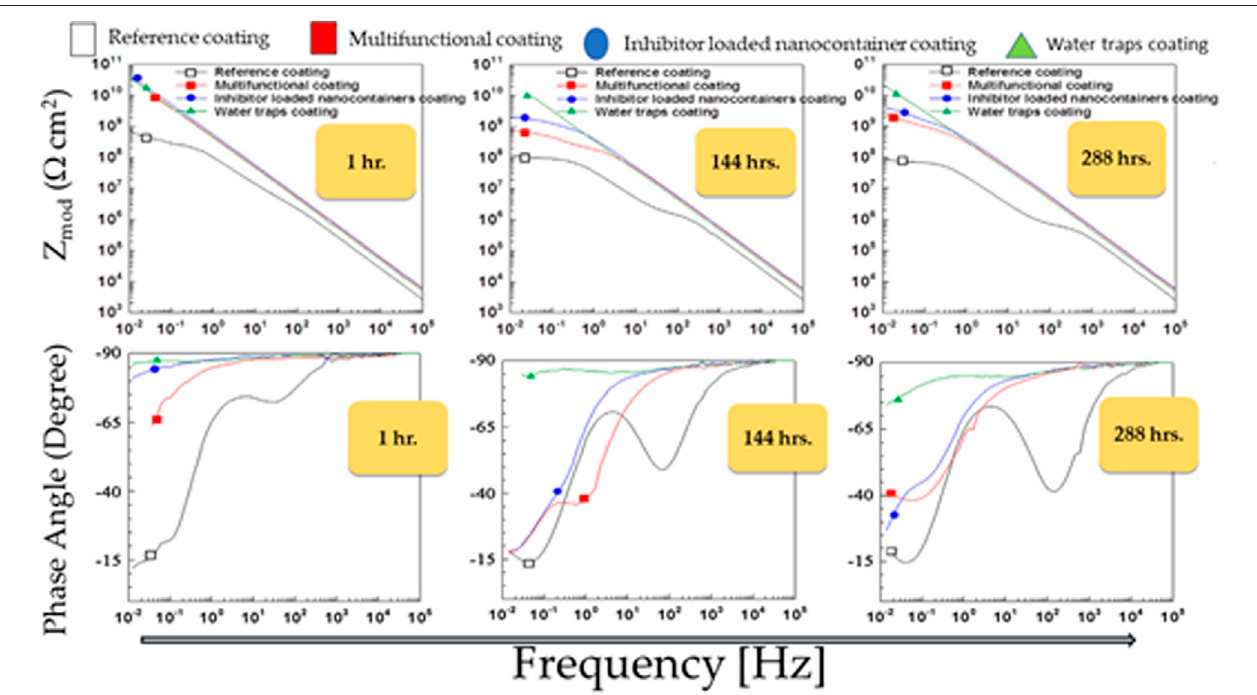
FIGURE 5 | FRA of the multifunctional coating on AA2024-T3 metals including inhibitor-loaded nanocontainers and nanotraps of water and chlorine exposed to 0.5 M NaCl (aq) for 1, 144, and 288 h.